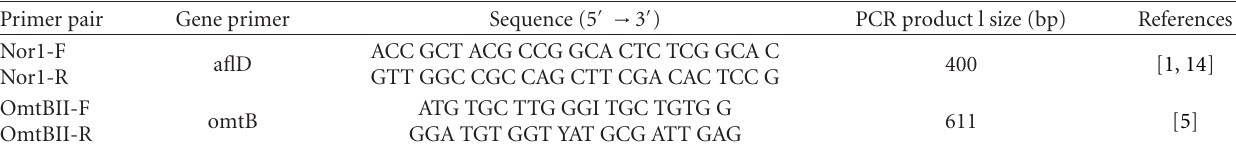
Table 1: The primer sequences of target genes and expected product length in base pairs (bp) for PCR amplified DNA fragments. Primer